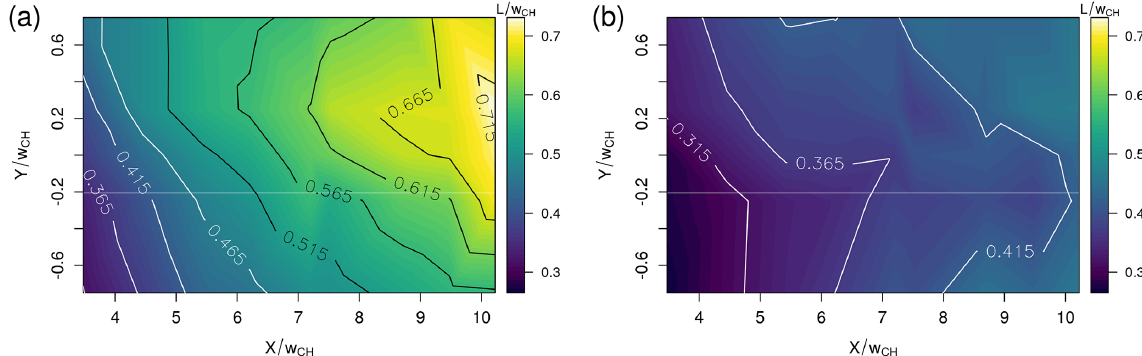
= 0 . 04Hz and (b) f = 0 . 4Hz. CH 2 1